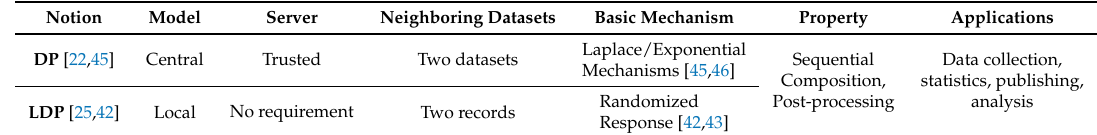
Figure 2. The general processing frameworks of DP and LDP. Table 2. Comparisons between LDP and